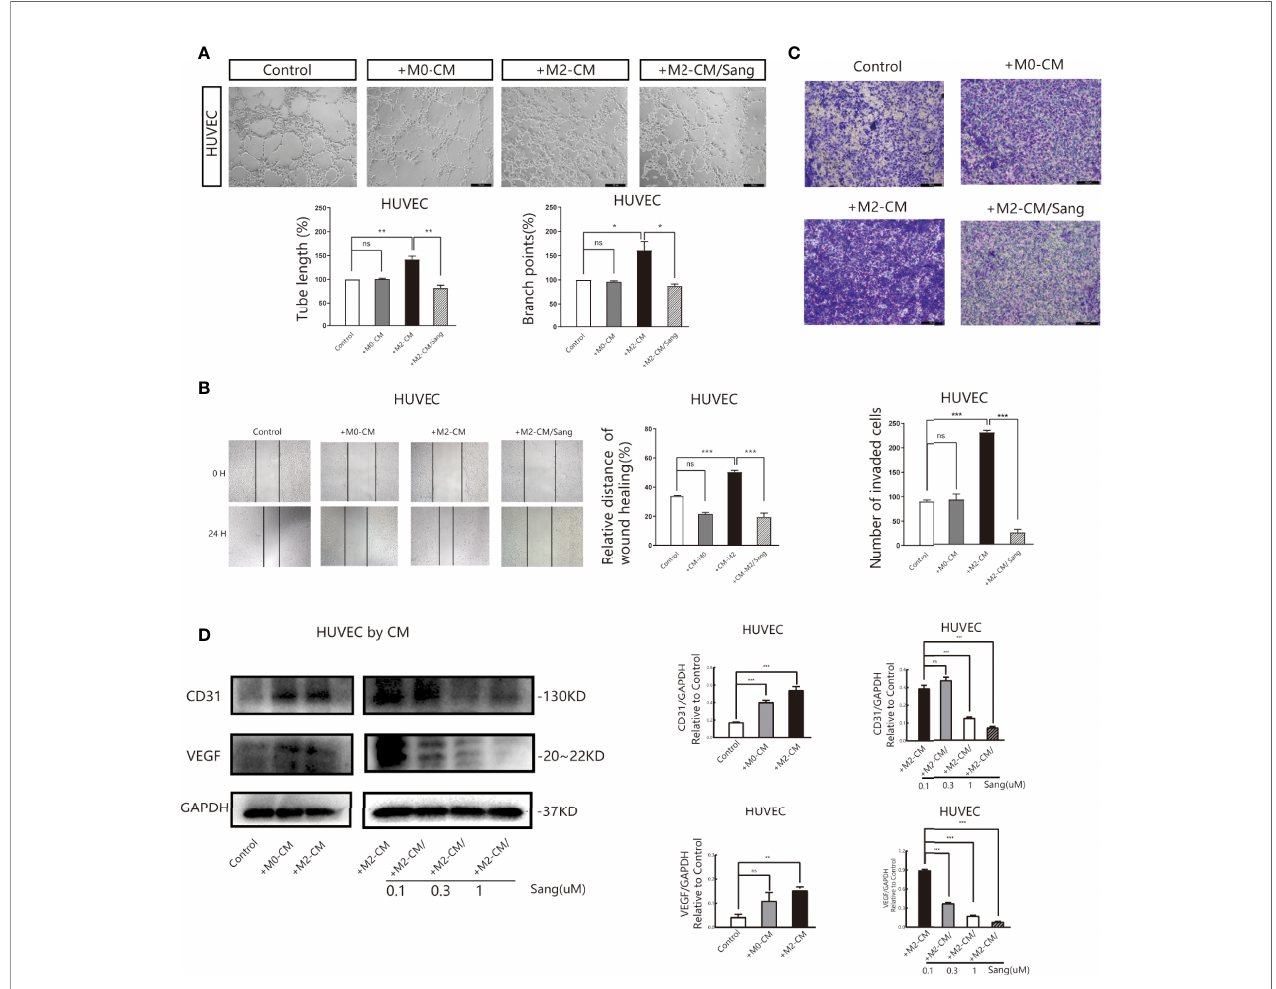
FIGURE 3 | Sang inhibits neovascularization by suppressing M2 macrophage polarization. Conditioned medium (CM) was used to determine the effects of Sang pre- treatment on angiogenesis promoted by M2-like macrophages. (A) Representative images of the HUVEC tube formation assay on Matrigel (magni fi cation 20x) and quanti fi cation of tubes and branch points. (B) Representative images of the HUVECs wound healing assay at 0 h and 24 h, as well as quantitative analysis of the wound healing area. (C) HUVECs migration and invasion was detected using a Transwell assay. HUVECs were plated in the upper chamber, and the conditioned medium of macrophages after different treatments was collected and placed in the lower chamber. Representative images of HUVECs invasion, as well as quanti fi cation of the number of migrated HUVECs (20X). (D) Western blot assay for CD31 and VEGF protein expression in HUVECs that were co-cultured with macrophage-CM, and treated with Sang. Each experiment was reproduced three times. *p < 0.05; **p < 0.01; ***p < 0.001; ns, not statistically signi fi cant (p >